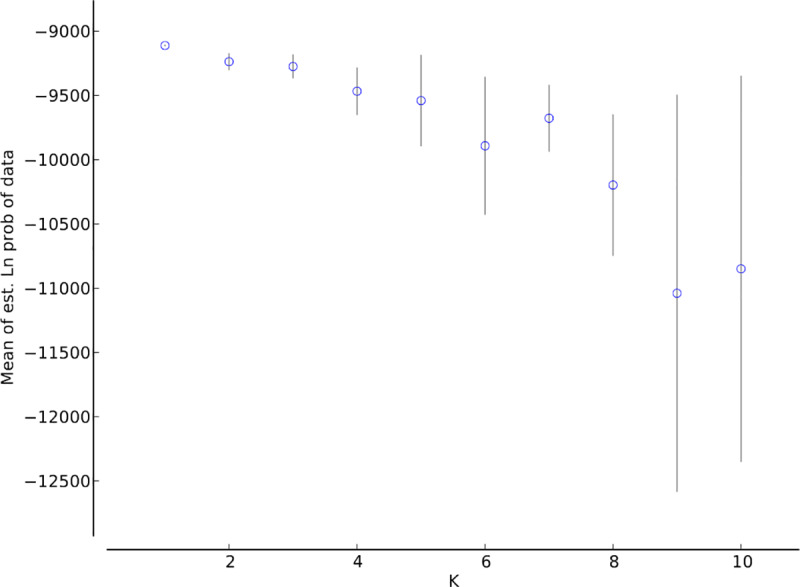
Structure L(K) plot, showing that the value of K with the highest likelihood is 1.